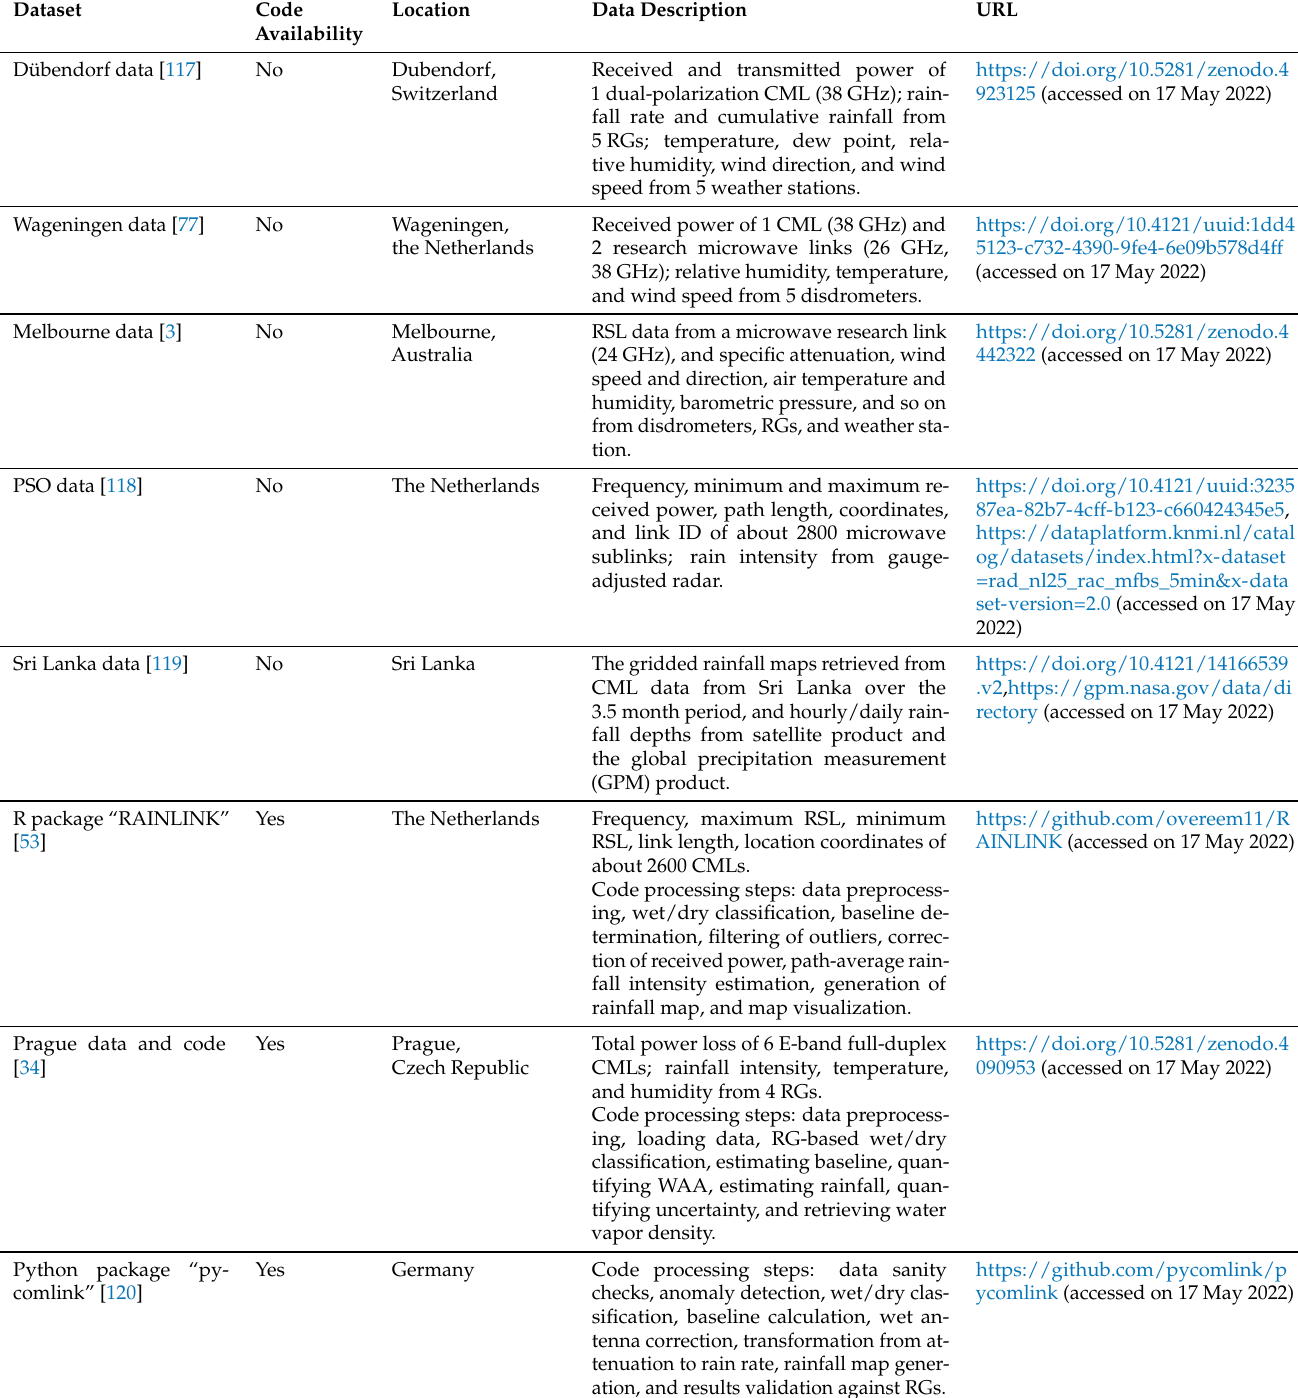
Table 4. Open-access